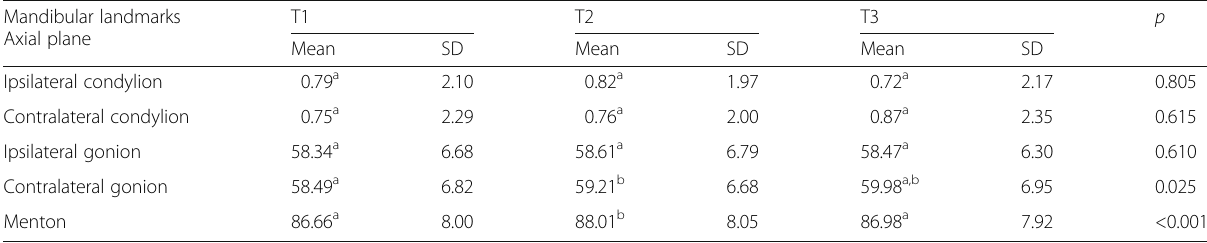
Table 1 Mean and standard deviation of distances (millimeter) between the mandibular landmarks and the axial plane observed at the three time-point evaluations. Results for repeated measures ANOVA Mandibular landmarks Axial plane